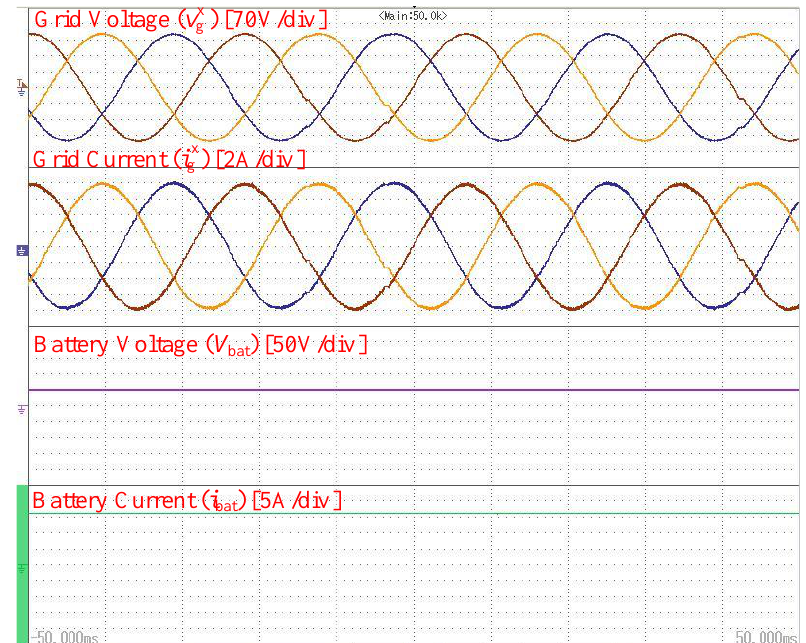
Figure 17. Experimental waveforms for three-phase battery charging. The V2G mode allows the injection of battery energy back into the grid. Grid-to-vehicle (G2V) charging and vehicle-to-grid (V2G) discharging modes are available for EVs. The interface must be capable of bidirectional power flow in order to use V2G mode. The proposed topology supports charging as well as discharging in its three-phase variants. Figure 18 depicts experiments in both modes of operation (G2V and V2G). When an ab- rupt change in the flow of the battery current is directed, the battery current is seen to be reversed. In this case, the grid current is 180° out of phase with the grid voltage. G2V mode + Figure 18. Bidirectional power flow with the proposed rectifier for V2G application.